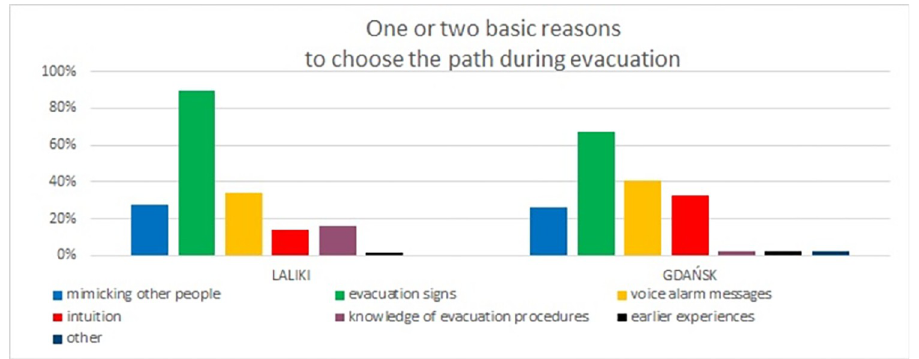
Fig 7. Reasons for choosing a specific evacuation path (results from Experiment